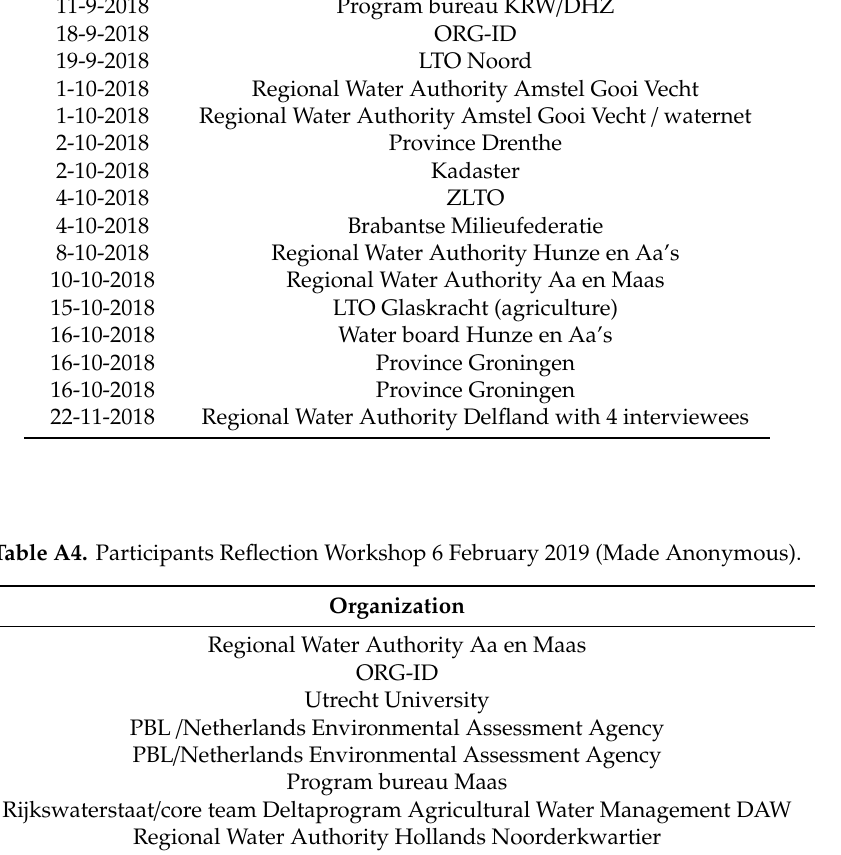
Table A3. List of Interviewees Dutch Report (Made Anonymous). Datum